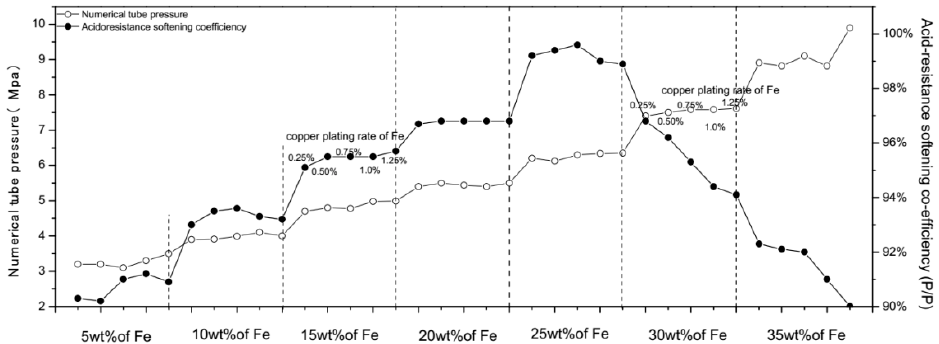
Figure 2. Numerical tube pressure and Acid-resistance softening co-efficiency test of CCF.